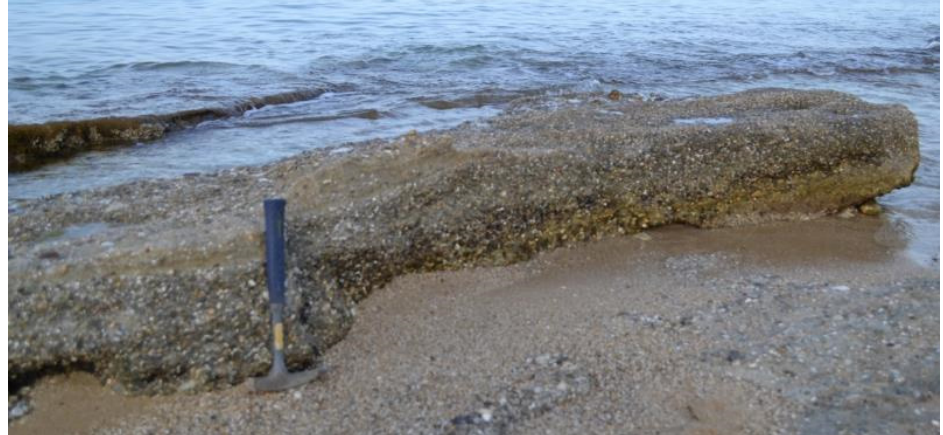
Figure 5. Details of the beachrocks in Lygia swimming